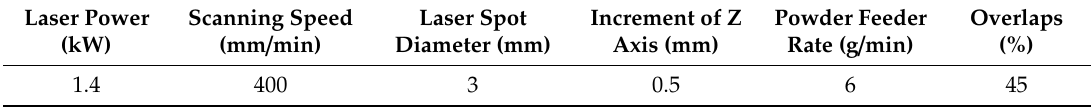
Figure 3. Schematic of the scanning strategy of the LAR process. Table 2. Process parameters of LARed Inconel 625 alloy.